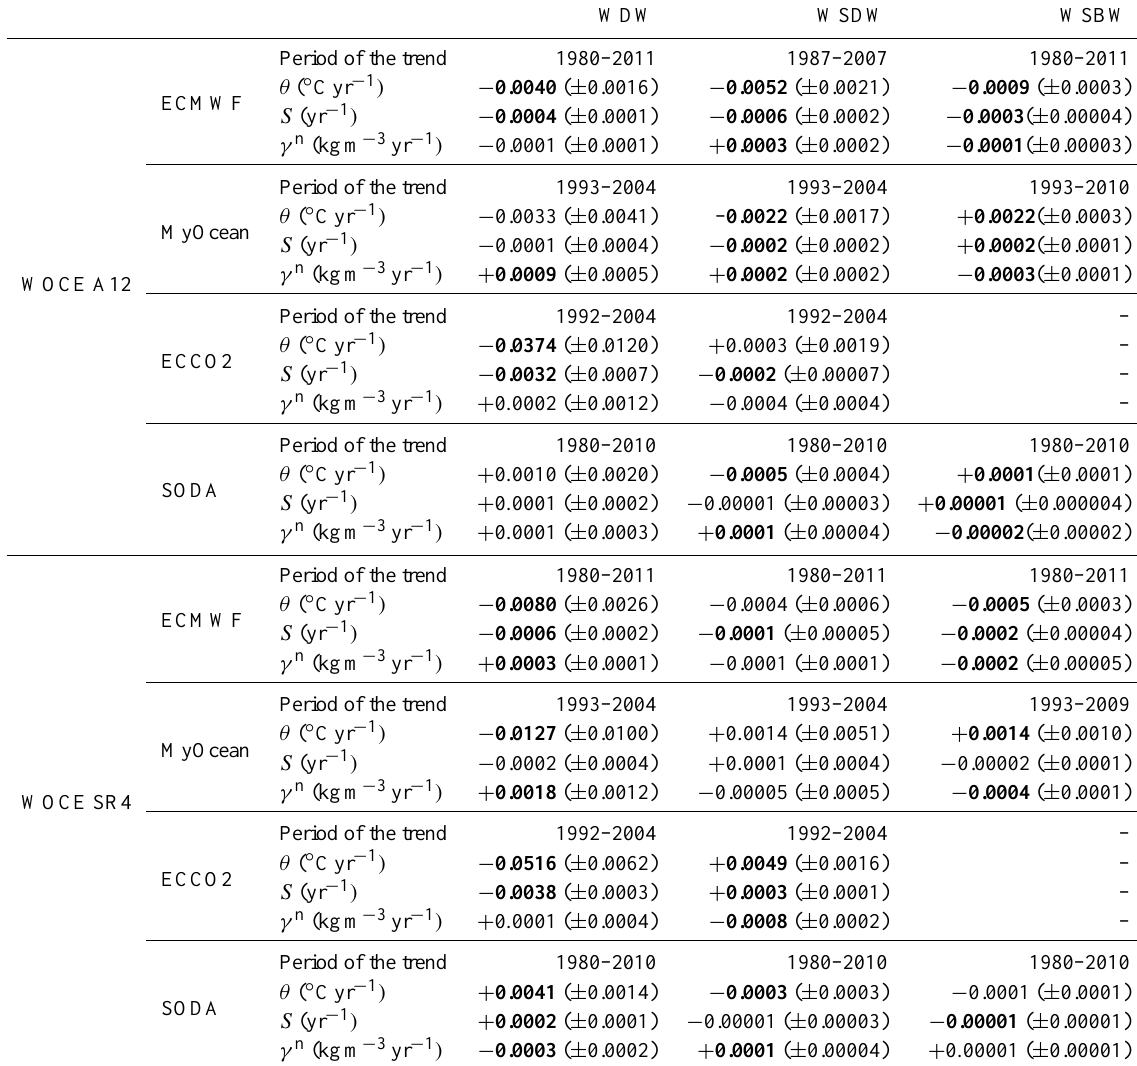
Table 4. Linear fits and confidence bounds (95% confidence) of the annual time series of hydrographic properties. Bold font indicates a statistically significant trend ( P ≤ 0.05). The period considered to determine the trends depends on the water mass in each